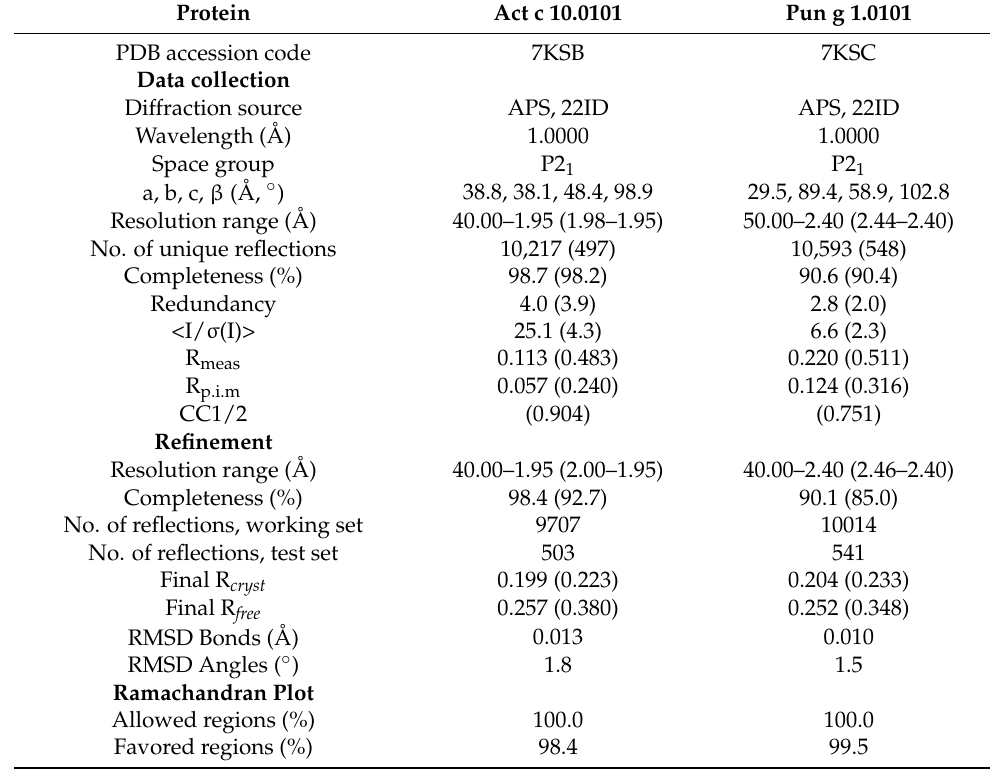
Table 1. Data collection and refinement statistics for Act c 10.0101 and Pun g 1.0101. Values in parentheses are for the highest resolution shell. RMSD—Root Mean Square